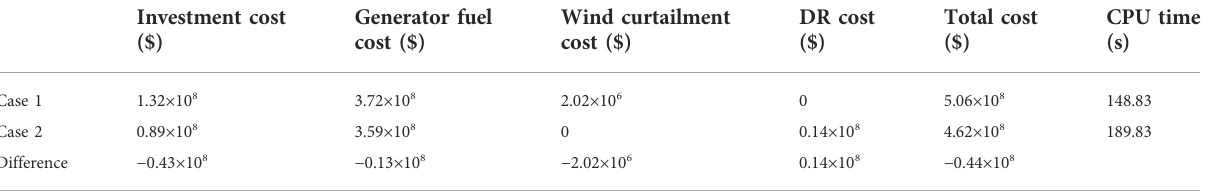
TABLE 3 Cost comparison between Case 1 and 2.